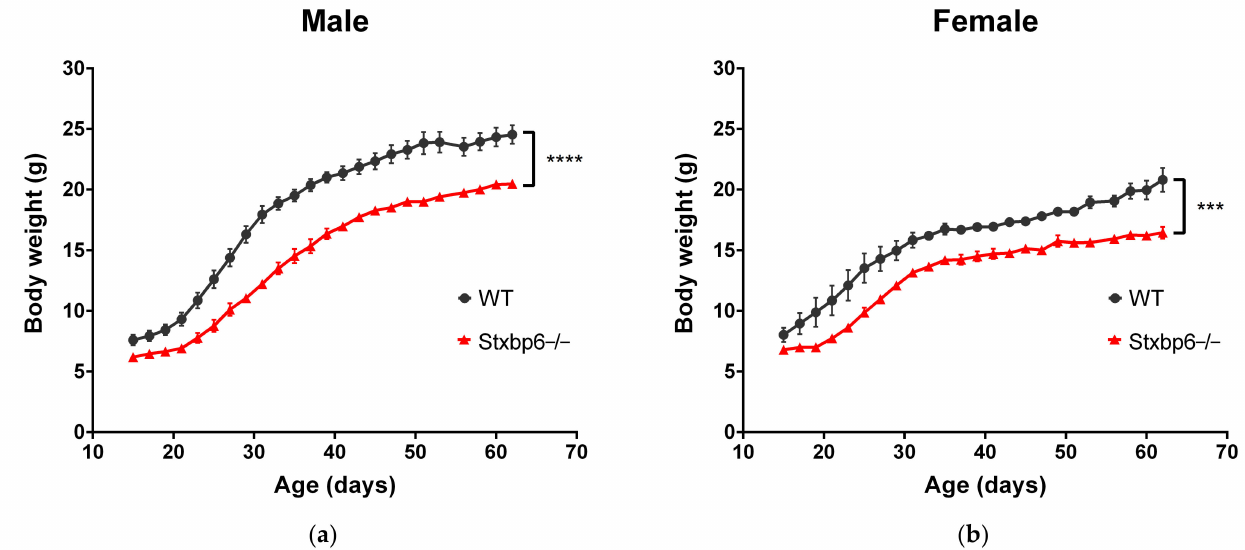
Figure 4. Mouse weights. ( a ) Monitoring of body weight over 7 weeks in male mice. Body weight effects: genotype (F(1, 11) = 35.76, p < 0.0001), age (F(23, 253) = 660.9, p < 0.0001); ( b ) Monitoring of body weight over 7 weeks in female mice. Body weight effects: genotype (F(1, 9) = 30.64, p = 0.0004), age (F(23, 207) = 141.4, p < 0.0001). *** p < 0.001; **** p <